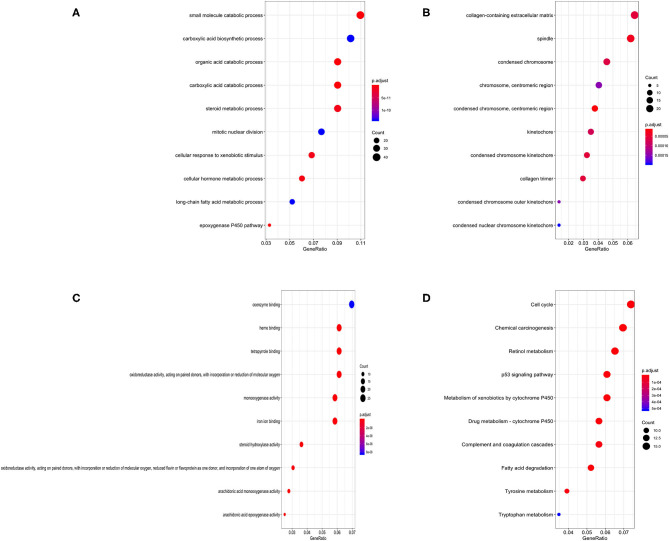
Bubble charts of enriched GO annotations and KEGG pathways for integrated DEGs. (A) The top 10 enriched biological process GO terms. (B) The top 10 enriched cellular component GO terms. (C) The top 10 enriched molecular function GO terms. (D) The top 10 enriched KEGG pathways.